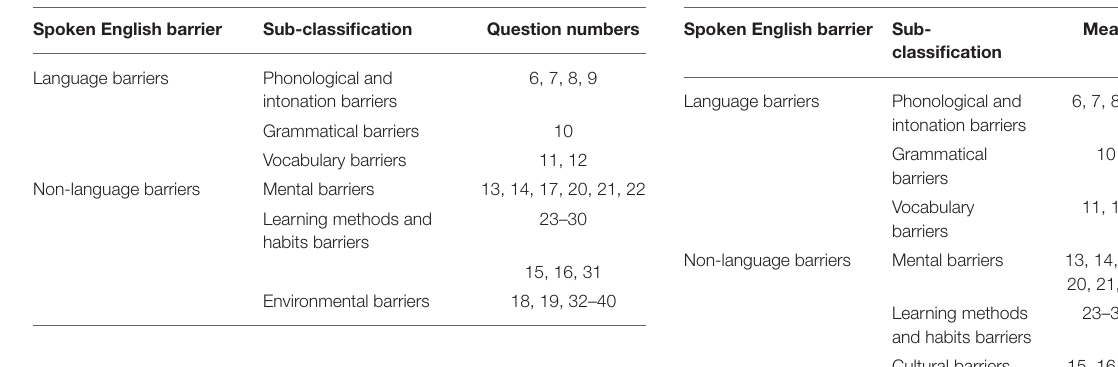
TABLE 3 | Spoken English barrier categories. TABLE 4 | Spoken English